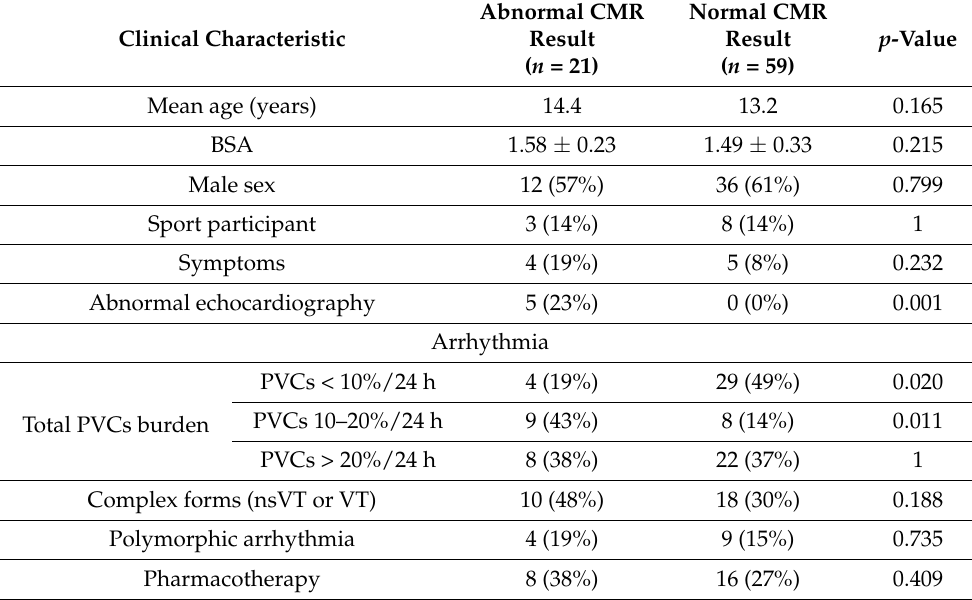
Table 2. Clinical characteristics of patients in relation to study endpoints.